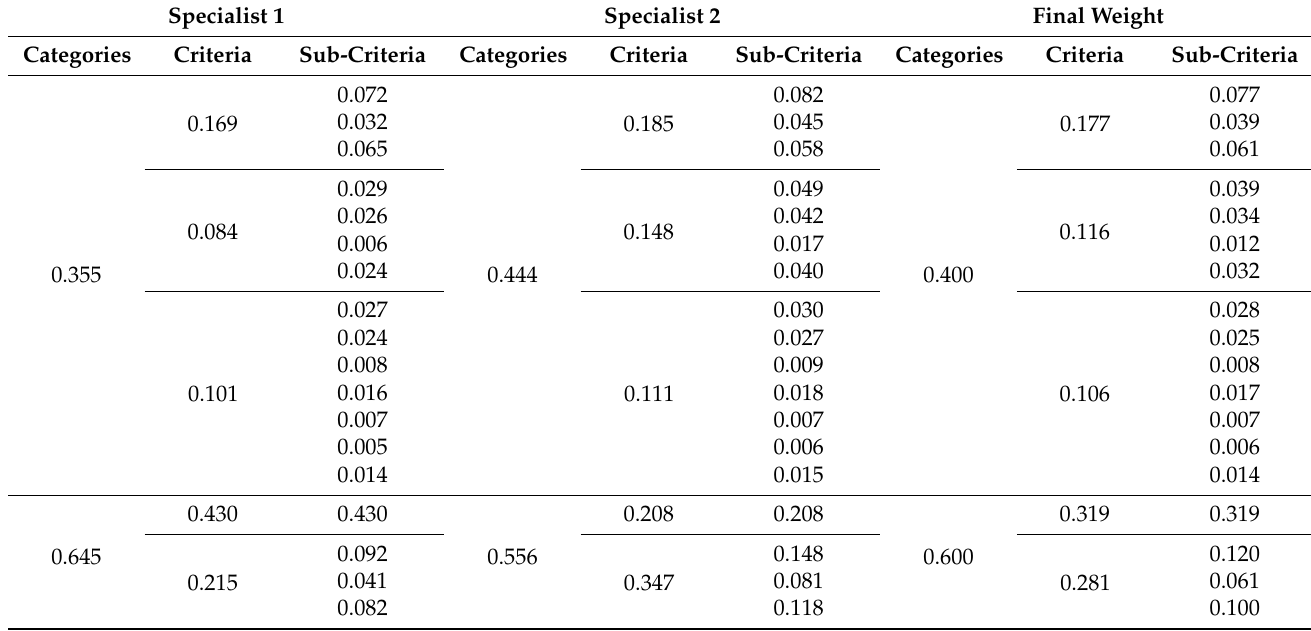
Table 2. Criteria weight.